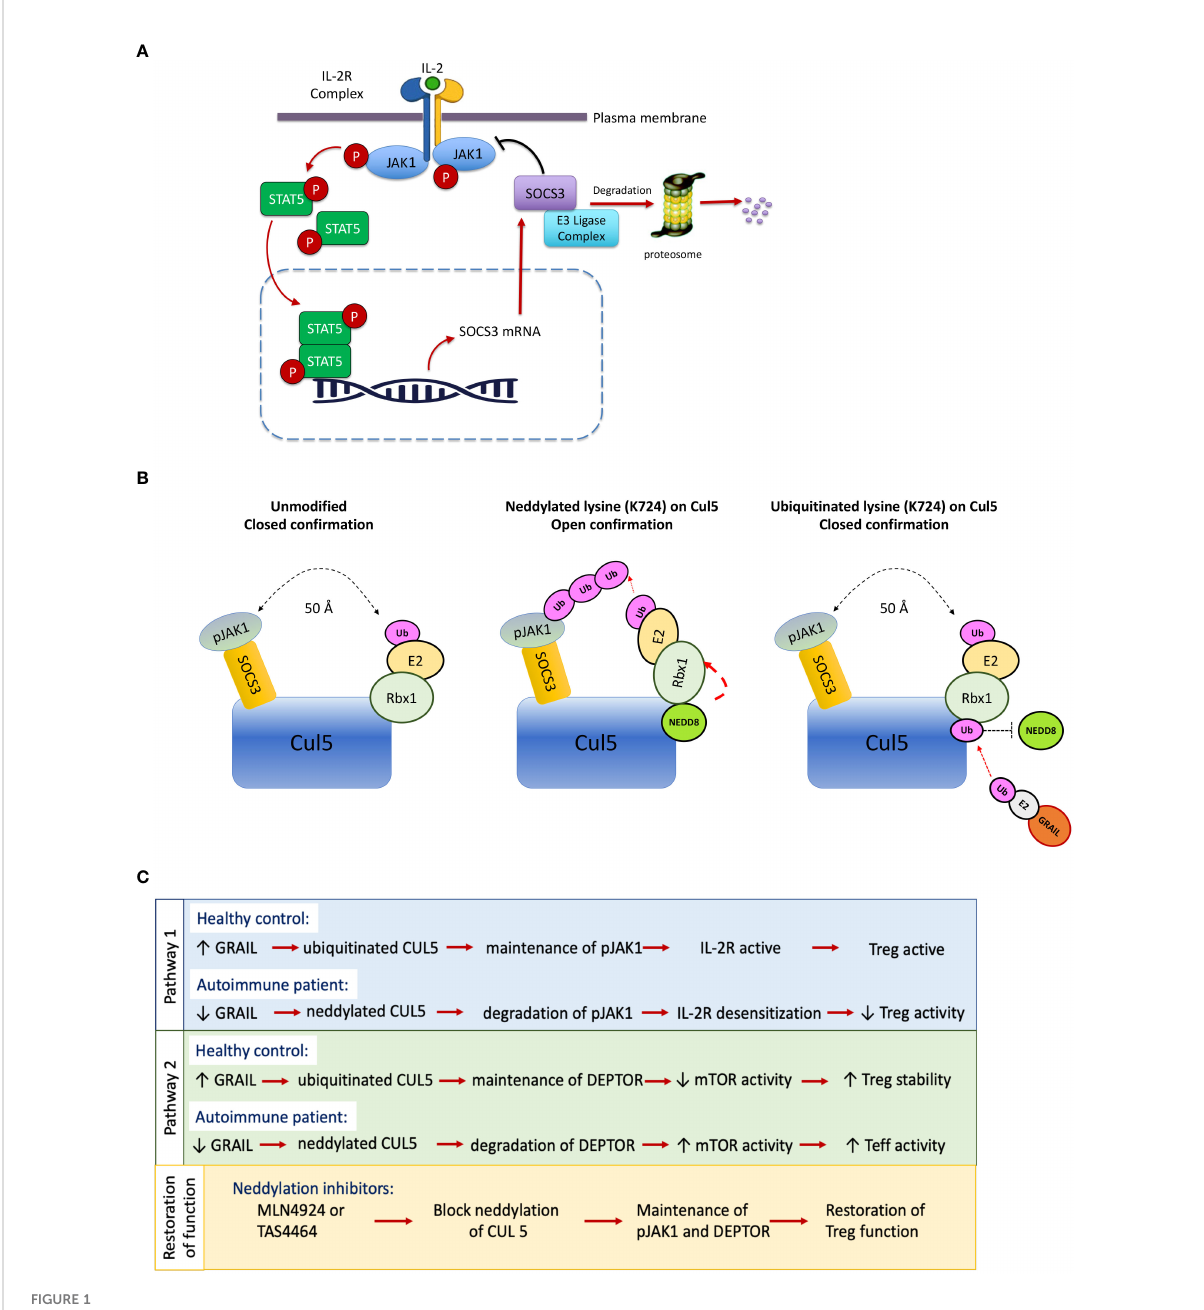
FIGURE 1 IL-2 receptor desensitization, neddylation of Cullin5 and restoration of T reg function. Desensitization of the IL-2R means turning it off. SOCS3 is a negative regulator of IL-2R b chain – associated pJAK1 and forms a cullin ring ligase to ubiquitinate pJAK1. (A) Healthy individuals inhibit IL-2R desensitization in their T regs by a protein, GRAIL, that is constitutively expressed in normal T regs . Patients with autoimmunity have a defect in this pathway of inhibition of desensitization. (B) Upon neddylation of Cullin5 (Cul5) at lysine 724, one end of the Rbx1 protein is untethered and undergoes a 50A shift, bringing the ubiquitin transferase (E2) in proximity of the target of the SOCS3, pJAK1, to transfer ubiquitin for degradation. GRAIL, constitutively expressed in T regs , is a competitive inhibitor of this process, as it ubiquitinates lysine 724 and does not allow neddylation and release of the E2 bound to the Rbx1 protein, thus inhibiting IL-2R desensitization. (C) Reduced GRAIL expression in autoimmune patients leads to diminished T reg function via two distinct pathways that favor the neddylation of CUL5. Treatment with neddylation inhibitors such as MLN9424 may restore T reg